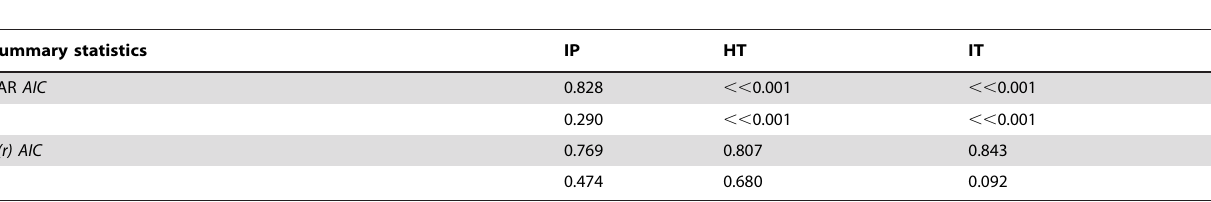
Table 1. The p-values from Kruskal-Wallis rank sum tests on SAR and g(r) AIC values across the point process models with and without size-class effect at DBH class 0 (that is: size-classes 1, 2 and 3